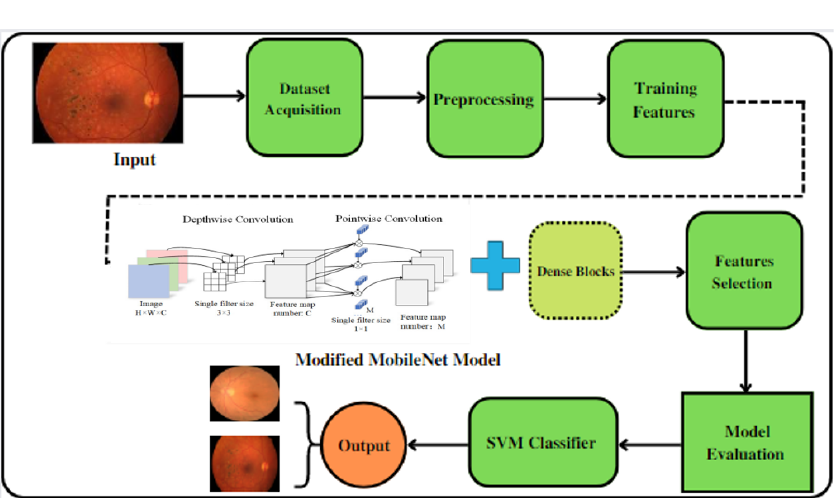
Figure 7. A schematic fl ow diagram of the proposed Mobile-HR system.